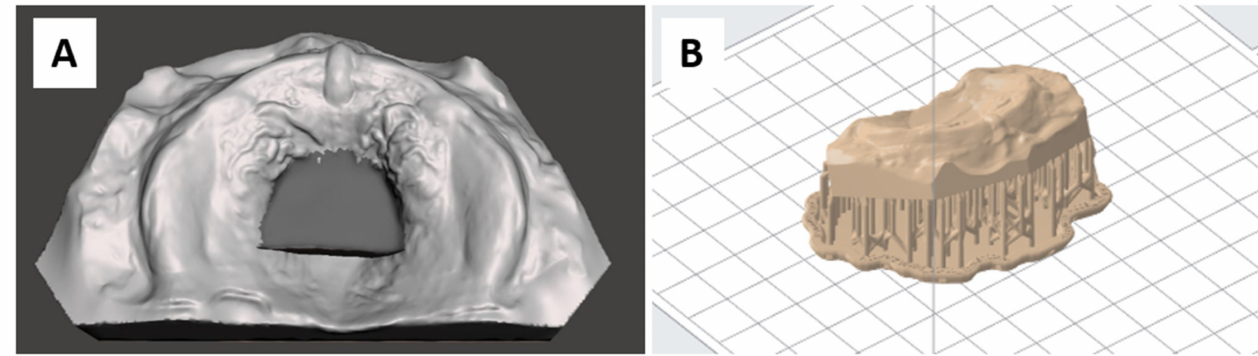
Figure 4. Model wax construction and printing preparation. ( A ): Wax placement in the palatal area of the model in Meshmixer 3.5. ( B ): Support placement and model positioning in Preform